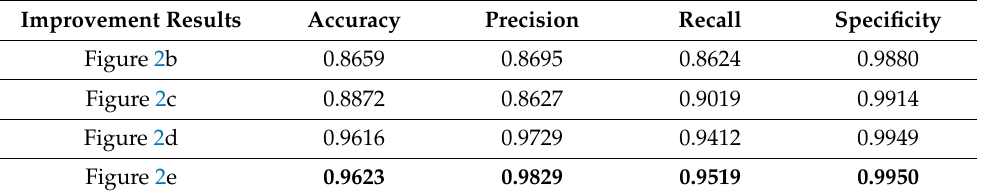
Table 1. Dates of the ablation experiments.